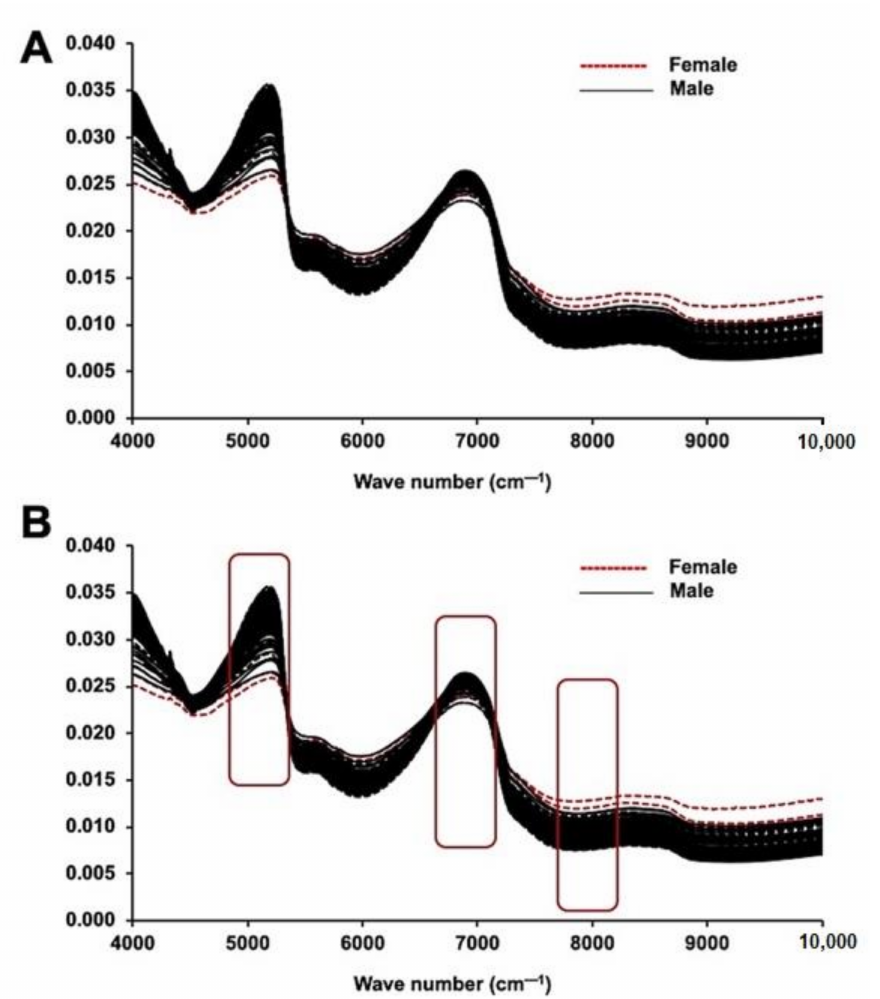
Figure 1. NIRS analysis of immature date palm leaf samples. ( A ) Raw NIR spectra (without pre- processing) and ( B ) pre-processed NIR spectra (Unit vector Normalization) of both male and female immature date palm leaf samples. The figure demonstrates the scattering effect in the wavenumber range of 4000 to 10,000 cm − 1 due to absorbance without preprocessing. The spectra represent the fifty individual samples each from male and female and that were tested five